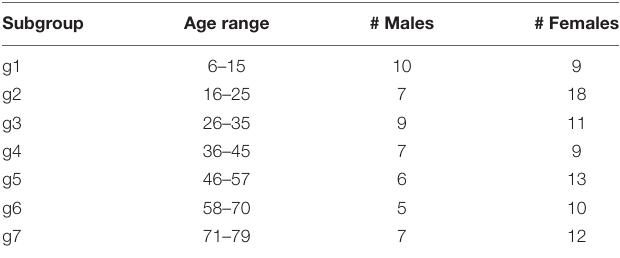
TABLE 4 | Subgroups of subjects, with the corresponding age ranges and cardinalities. Subgroup Age range